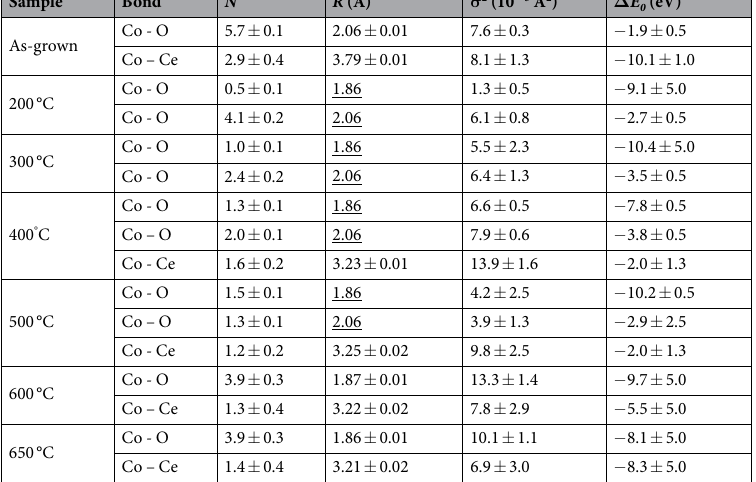
the EXAFS functions using an improved curve-fitting procedure with back scattering amplitude and phase shifts functions obtained from the FEFF software 19, 20 . The amplitude reduction factor S 02 representing the central atom shake-up and shake-off effects and the mean free path of photoelectrons λ were set to be 0.72 and 10 Å as deter- mined in previous papers 21, 22 . The final values of fitting parameters for the Co K-edge EXAFS are listed in Table 1. For the as-made sample, the EXAFS data exhibit a nearest O shell at 2.06 Å and a Ce next nearest shell at 3.79 Å from the Co central atom as shown in Table 1. The coordination number of the nearest O neighboring shell is around 6, roughly two less than that of 8 surrounding Ce in the CeO 2 host. Compared to the 2.34 Å Ce-O distance and 3.83 Å Ce-Ce distance calculated from the standard crystal structure 19 of CeO 2 , the observed Co-O and Co-Ce distance indicate that the Co dopant atoms most likely substitute for Ce atoms in the CeO 2 matrix with large distortion arising from the surrounding oxygen vacancies. After thermal annealing, the amplitude of the peak due to the 2.06 Å Co-O bond decreases while a new peak representing a much shorter (1.86 Å) Co-O bond appears and intensifies as the annealing temperature increases. The Co-Ce bond length also decreases from the as-made value of 3.79 Å to 3.22–3.25 Å in the samples annealed at 400–600 °C. For the 650 °C annealed sam- ple, the Co-O and Co-Ce bond lengths are around 1.86 Å and 3.21 Å, respectively. The coordination number of the nearest O neighboring shell is also reduced from 6 to 4. We ascribed this dramatic reduction of Co-O bond length and O coordination number surrounding Co to the change of Co dopant location in the CeO 2 host due to thermal annealing. To reveal the coordination geometry around Co atoms, the experimental XANES spectra were compared with theoretical simulation based on the multiple-scattering (MS) formalism using the FDMNES code 20 . Local struc- tural information obtained from EXAFS analysis were used to construct the theoretical model. The self-consistent muffin-tin (MT) full-multiple-scattering (FMS) approach with the real Hedin-Lundqvist exchange-correlation potential was applied with a cluster radius R = 2.1 Å that corresponds to 7 and 5 atoms for the octahedral model and the square planar model, respectively. The FMS calculations were performed using the MT potential con- structed from 10% overlapped MT spheres. For the as-made and 650 °C annealed samples, an octahedral and a square planar ligand models with 6 and 4 Co-O bonds were adopted, respectively. As shown in Fig. 3(c), it is clear that the theoretical simulation agrees rather well with the experimental XANES data. Therefore, our x-ray results show that the Co dopant atoms can be driven by thermal annealing from an octahedral coordination in the as-made sample to a square planar coordination. To understand the observed correlation between band gap changes and cobalt local structure transition, density functional theory (DFT) calculations were performed using the Vienna ab initio simulation package (VASP) 23 . A generalized gradient approximation (GGA) PBEsol functional 24 was adopted and a 6.5 eV Hubbard U correction 25–27 to the Ce 4 f orbitals was employed to describe the correlation effects of the Ce 4 f states in defec- tive CeO 2 crystals. A 2 × 2 × 2 supercell with 96 atoms therein was used as the initial model for pure CeO 2 . The Brillouin-zone (BZ) integration was performed using a 4 × 4 × 4 Monkhorst- Pack k-point grid 28 . The plane-wave kinetic energy cutoff was set to be 400 eV. Atomic positions and lattice parameters of all models were optimized until the maximum force on each atom was smaller than 0.02 eV/Å. The structural model with octahedrally coor- dinated Co atoms shown in Fig. 5(a) was constructed by substituting a Ce atom in the ceria host with a Co atom, where two O neighboring atoms were removed from the diagonal sites of a CoO 8 cube forming an octahedral coordination geometry. In the model with Co dopant atoms in square planar coordination shown in Fig. 5(b), a Co atom was located in the center of the bottom face of a CoO 8 cube with four O atoms on the top face removed.